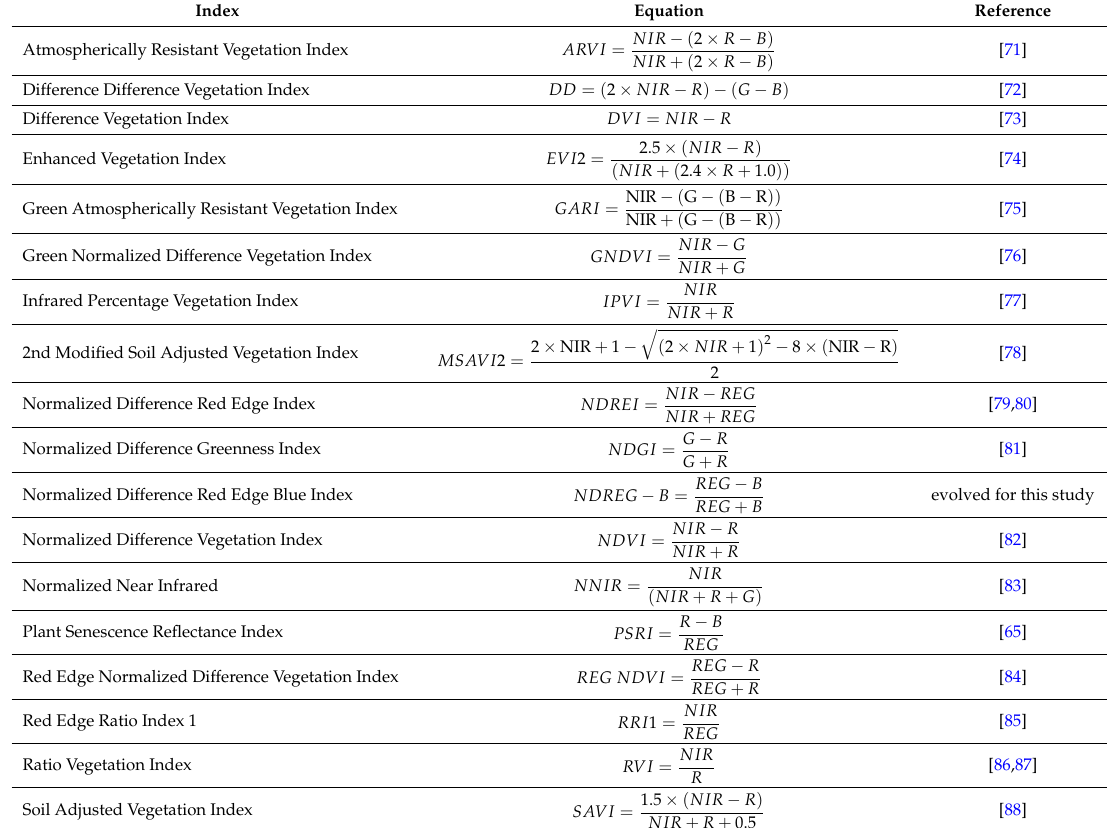
Table A1. Vegetation indices used for the change detection